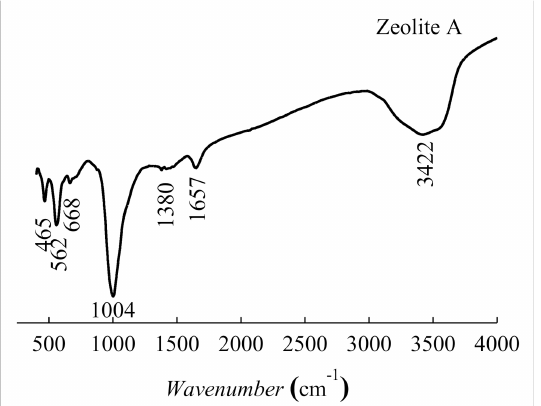
Figure 8. Infrared spectra of zeolite A synthesized by solid-phase alkali fusion.